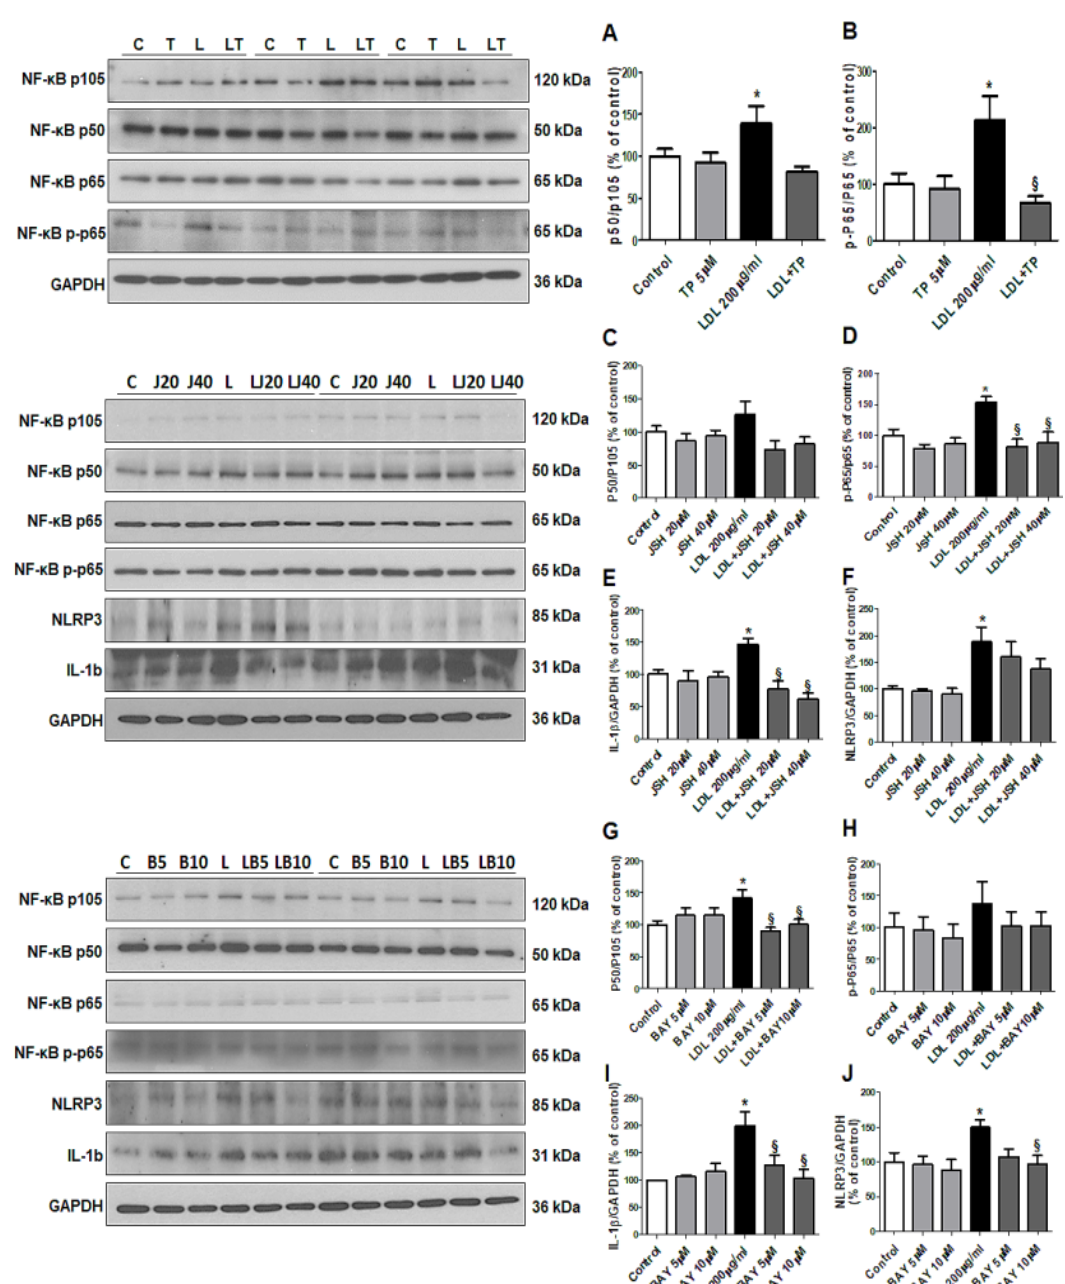
Figure 6. E ff ects of xanthine oxidase inhibitor on progression of inflammation through the NF- κ B pathway in LDL-treated HK-2 cells. ( A , B ) Representative western blot for NF- κ B p50 / p105 ratio, NF- κ B p-p65 / p65 ratio, and GAPDH in cells that were pretreated with TP (5 µ M) for 1 h, and then stimulated with LDL (200 µ g / mL) for 30 min. ( C – F ) Representative western blot for NF- κ B p50 / p105 ratio, NF- κ B p-p65 / p65 ratio, IL-1b, NLRP3, and GAPDH in cells that were pretreated with NF- κ B inhibitor (JSH23) for 1 h, and then stimulated with LDL (200 µ g / mL) for 30 min. ( G – J ) Representative western blot for NF- κ B p50 / p105 ratio, NF- κ B p-p65 / p65 ratio, IL-1b, NLRP3, and GAPDH in cells that were pretreated with NF- κ B inhibitor (BAY11-7028) for 2 h, and then stimulated with LDL (200 µ g / mL) for 30 min. Relative protein expression was determined using densitometry. Di ff erences among the groups were analyzed by a one-way non-parametric ANOVA, followed by Tukey’s multiple comparison test. Data represent mean and SEM. * p < 0.05 vs. Control, § p < 0.05 vs. LDL. LDL, low-density lipoprotein; TP, topiroxostat.